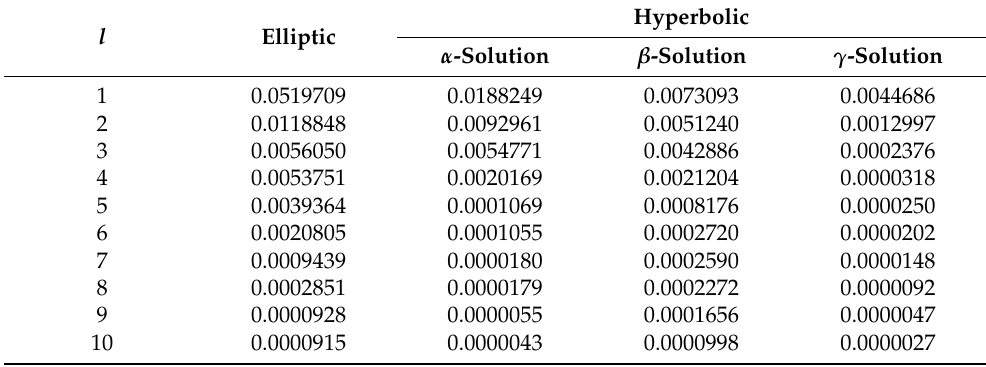
√ Table 5. The MSE of polynomial regression method of orders l = 1, . . . ,10 in estimating the critical collapse response function g ( z ) = | f 0 ( z ) | in elliptic and hyperbolic cases based on a training sample of size n = 100.